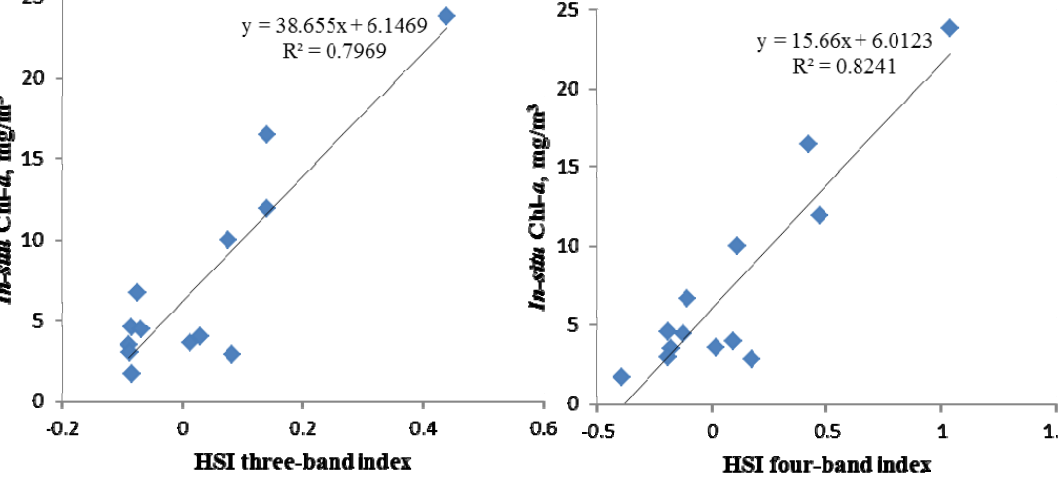
Figure 7. Linear regression and accuracy assessment of the two indices with hyperspectral reflectance of HJ-1A. ( a ) Three-band index regression; ( b ) Four-band index regression.